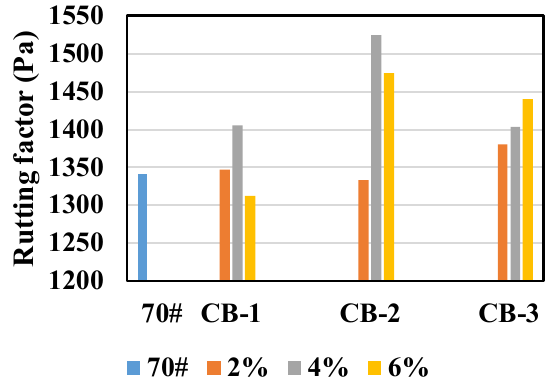
Figure 4. Rutting factor of unaged asphalt specimens.